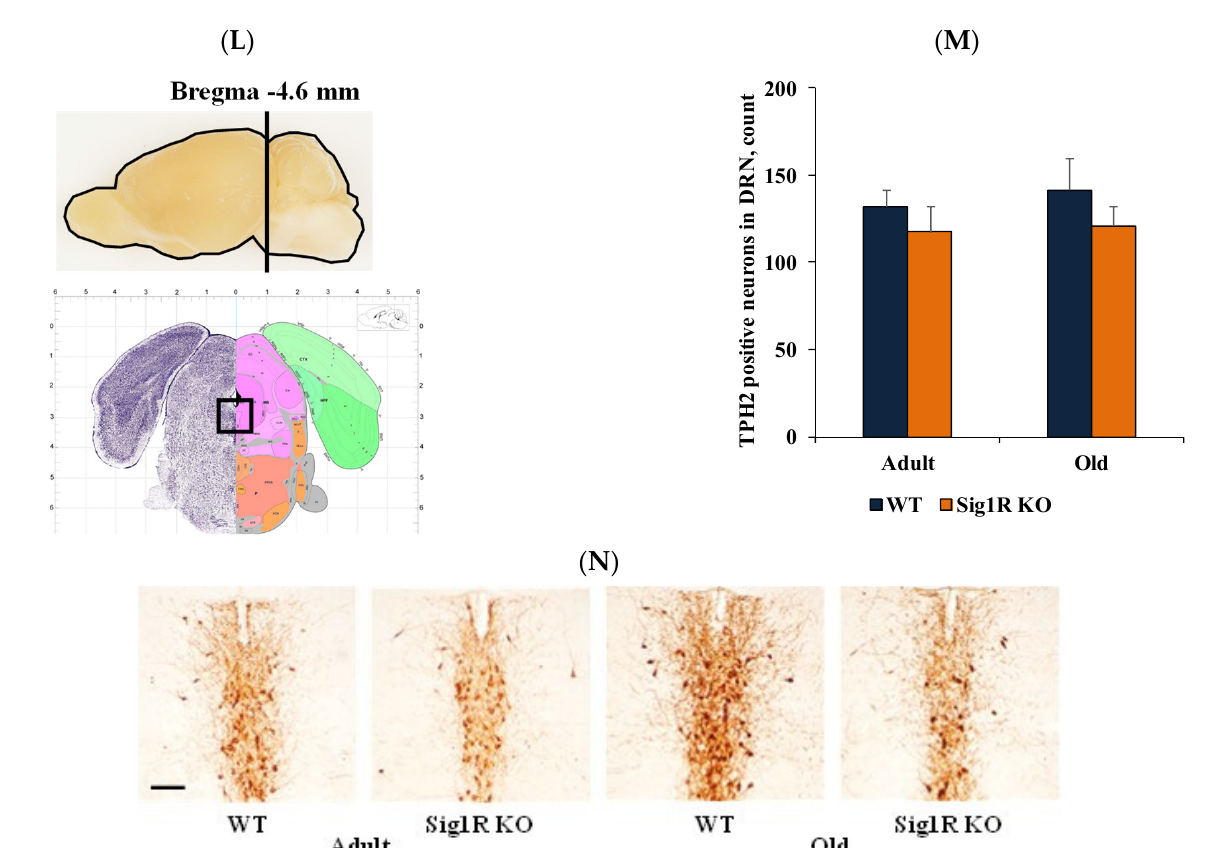
Figure 3. Reduced behavioral despair was associated with increased serotonin concentrations in Sig1R KO mice. ( A ) Immobility time (s) of young (2 months), adult (6 months), and old (15 months) WT and Sig1R KO mice was measured using the tail suspension test ( n = 6–15 mice/group; two-way ANOVA followed by the Sidak test). ( B ) 5-HT receptor gene ( Htr1a, Htr1b, Htr2a, Htr2c, and Htr3a ) expression in the prefrontal cortex, striatum, midbrain, hypothalamus, hippocampus, and cortex of adult (4 months) WT and Sig1R KO mice ( n = 8 mice/group; unpaired t test). ( C ) Water consumption of old (14 months) Sig1R KO ( n = 6 mice/group) and WT ( n = 8 mice/group) male mice was measured using the PhenoMaster system (shaded area indicates dark hours 8 a.m.–8 p.m.). ( D ) Sucrose solution consumption of old (14 months) Sig1R KO ( n = 6 mice/group) and WT ( n = 8 mice/group) male mice was measured using the PhenoMaster system (shaded area indicates dark hours, 08:00–20:00). ( E ) Combined consumption of water and sucrose solution (% of body weight) by young (2 months) and old (14 months) mice was measured using the PhenoMaster system ( n = 6–13 mice/group; unpaired t test). ( F ) Calculated sucrose preference (%) of young (2 months) and old (14 months) mice was measured using the sucrose preference test ( n = 6–13 mice/group; unpaired t test). ( G ) Serotonin concentration in the plasma of adult (6 months) and old (18 months) Sig1R KO and WT mice ( n = 6–7 mice/group; unpaired t test). ( H ) Serotonin concentration in brain tissue of adult (6 months) and old (18 months) Sig1R KO and WT mice ( n = 6–7 mice/group; unpaired t test). ( I – K ) Anatomical position for 5-HT and ( L – N ) TPH2 staining was validated using the Allen Mouse Brain atlas (http://mouse.brain-map.org/static/atlas, accessed on 18 May 2020). ( J ) Measured optical density (OD) of the staining intensity of 5-HT in the cortex ( n = 6 mice/group; two-way ANOVA followed by Tukey’s test). ( K ) Representative histological images of 5-HT staining in the cortex (scale bar = 300 µm). ( M ) Number of TPH2-stained cells in the dorsal raphe nucleus (DRN) ( n = 6 mice/group). ( N ) Representative histological images of TPH2 staining in the DRN (scale bar = 100 µm). Data are shown as the mean ± SEM (* p < 0.05 vs. WT; & p < 0.06 vs. WT; # p < 0.05 vs. same water consumption group).